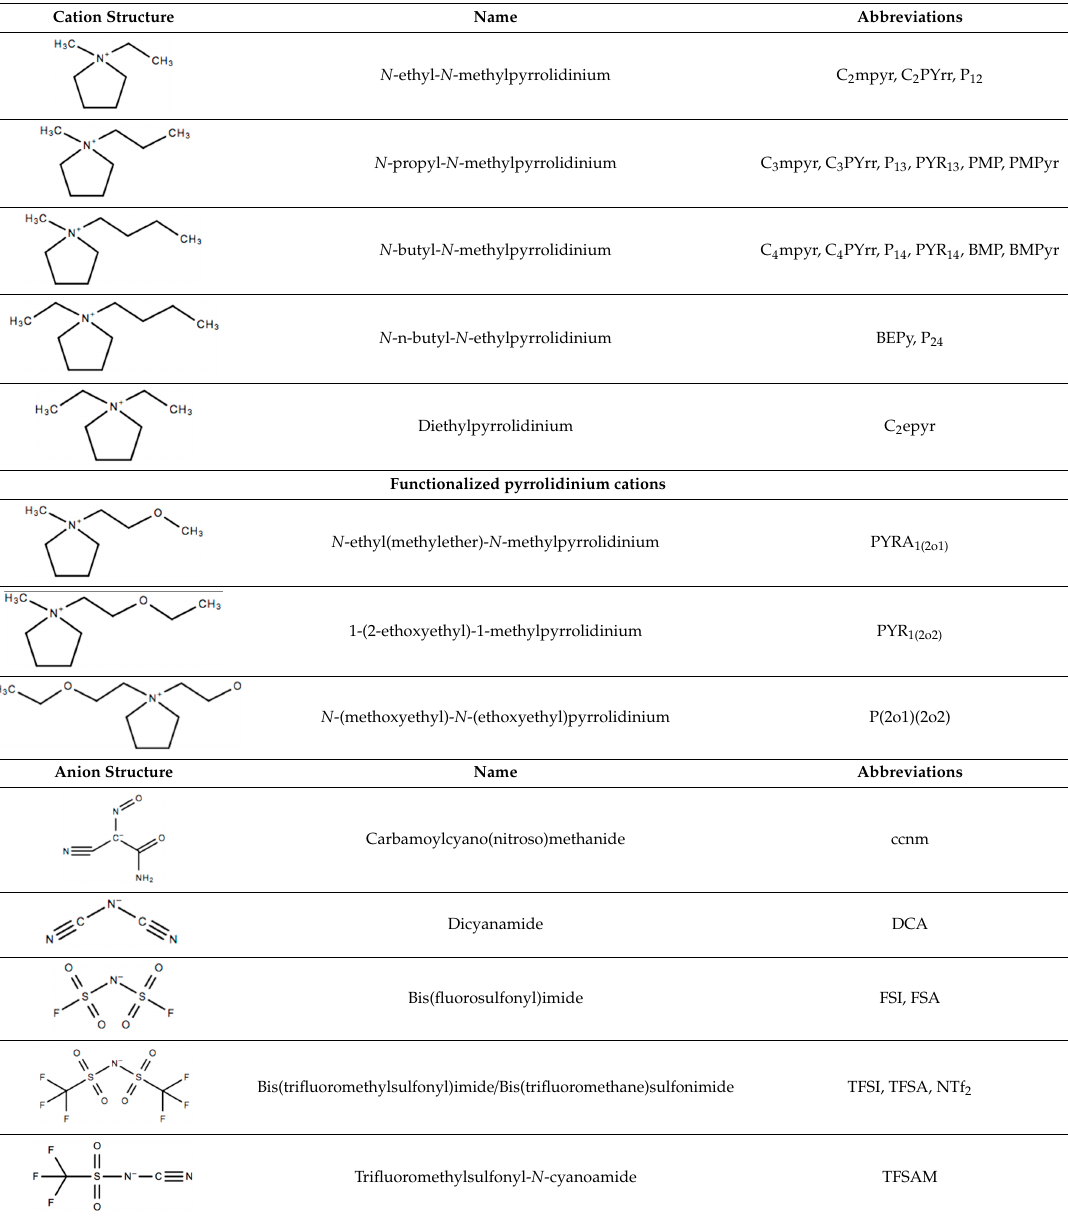
Table 1. Structures of pyrrolidinium cations and commonly used anions discussed in this review. Cation Structure